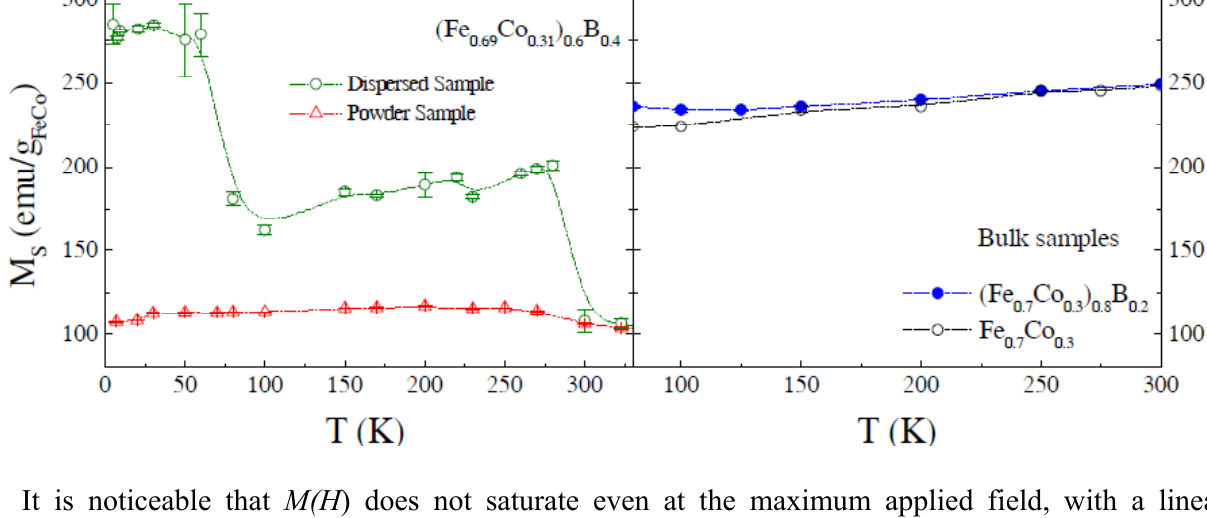
Co )B particles, and the bulk 0.69 0.31 0.4